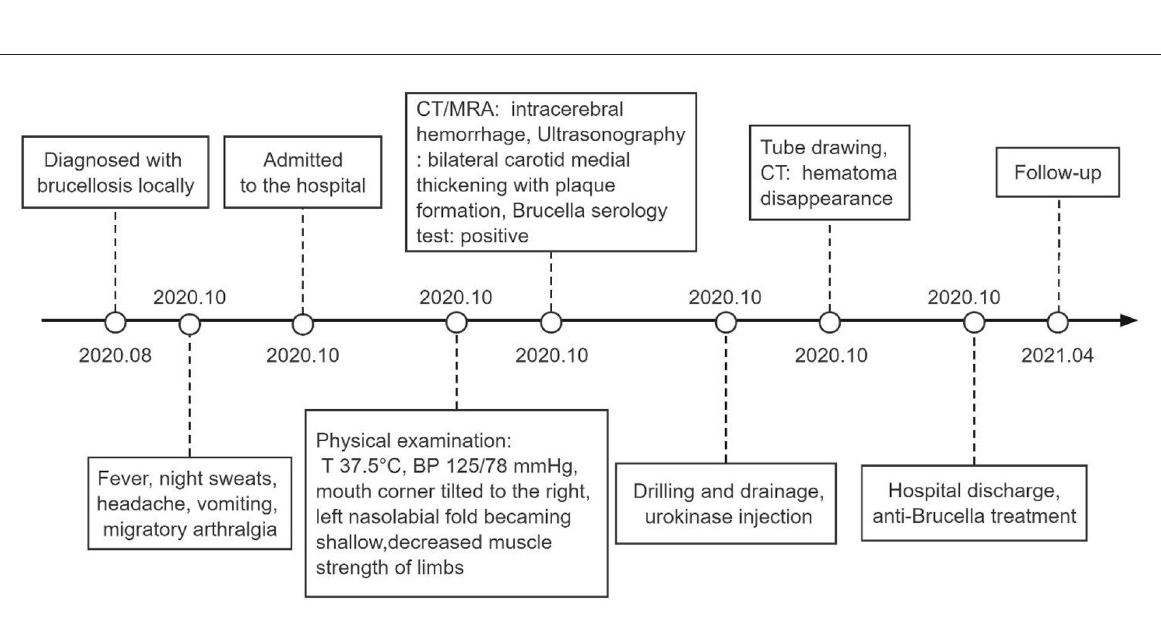
weeks and oral doxycycline (100mg twice daily) for 45